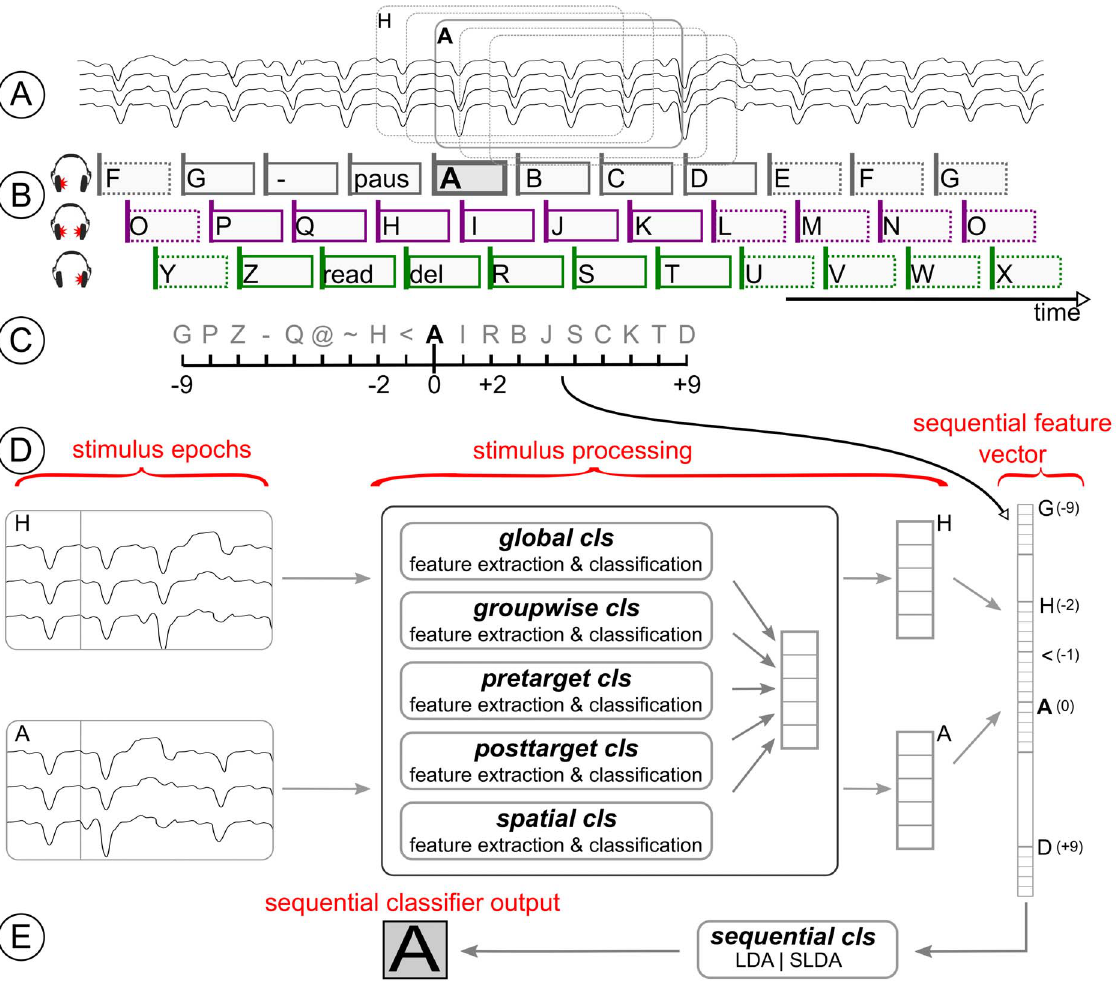
Figure 3. Design of the meta classifier which is optimized for sequential stimuli. Plots A and B illustrate the EEG epochs and the stimulation sequence in condition C. Plot C shows the range of EEG epochs which were considered in order to compute the sequential classifier output with m=9. Plot D depicts the processing pipeline of stimulus epochs: each epoch was evaluated by up to five classifiers and the resulting classifier outputs were considered as features of the sequential classifier. The sequential feature vector is evaluated by a meta classier which computes a sequential classifier output for the epoch of interest ( E ).